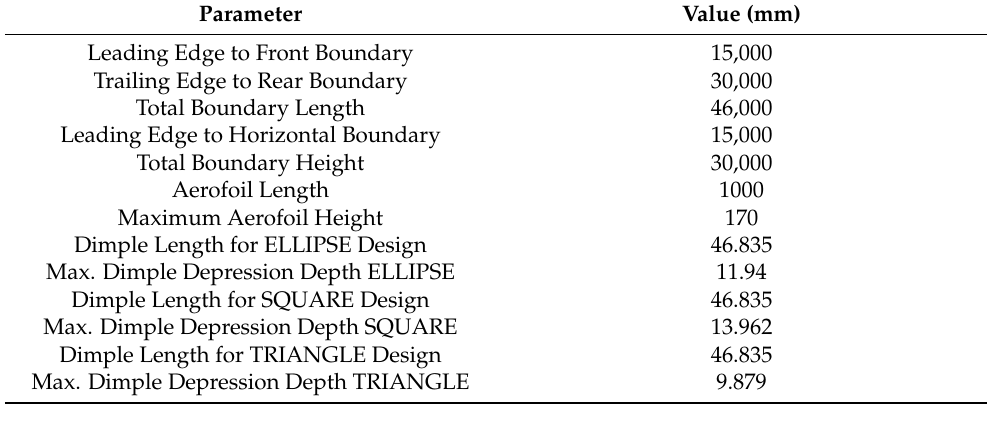
Table 2. Parameters for the enclosure for the aerofoil dimple designs in 2D.